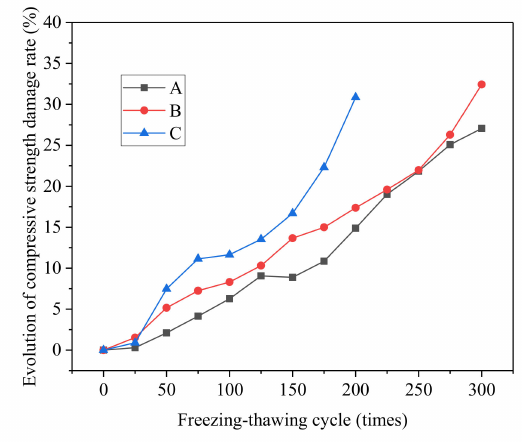
Figure 5. Compressive strength loss rate of